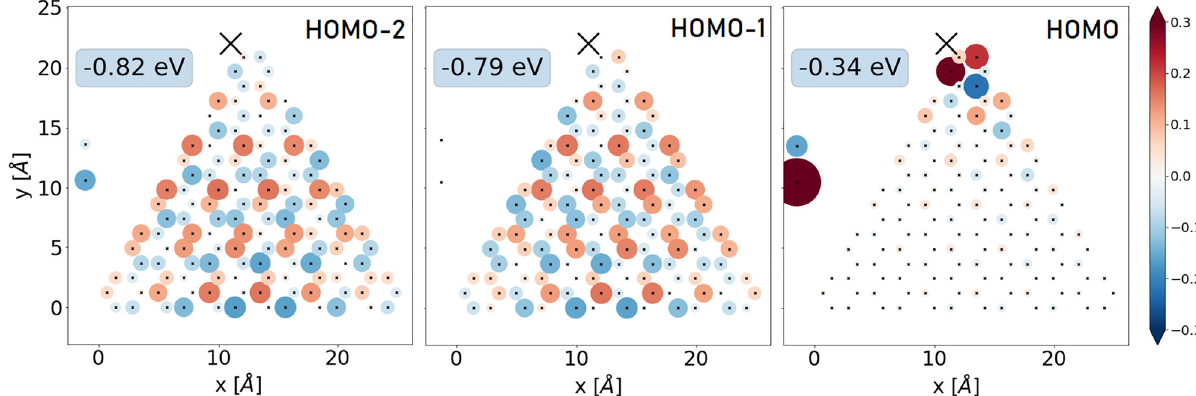
Figure 10: Real-space distribution of the HOMO, HOMO − 1 and HOMO − 2 states in a 126-atom flake with the adatom attached with a coupling = t = 2.0 eV near the tip of the flake at coordinates (11, 22) Å . The black mark X denotes the location of the adatom in the XY strength of t e g